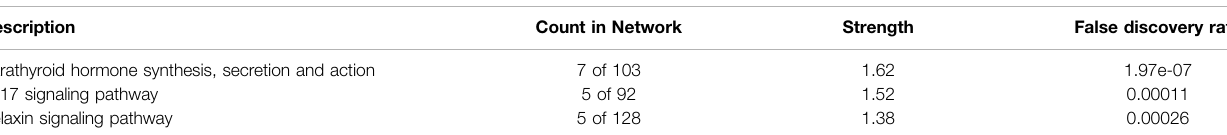
TABLE 1 | KEGG pathway enrichment of MMPs